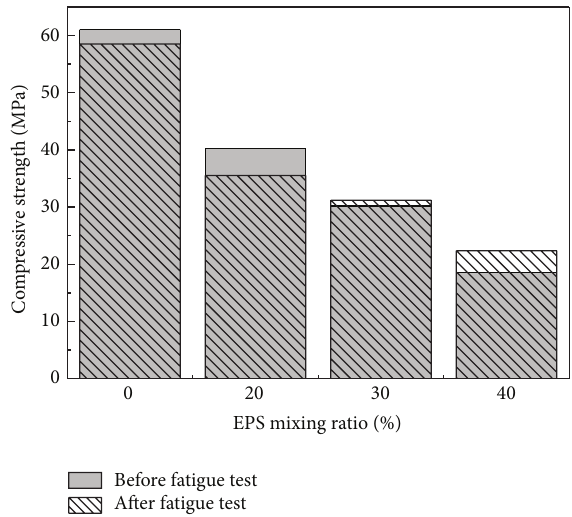
Figure 9: Later strength of 40 KN 50000-time cyclic loading.